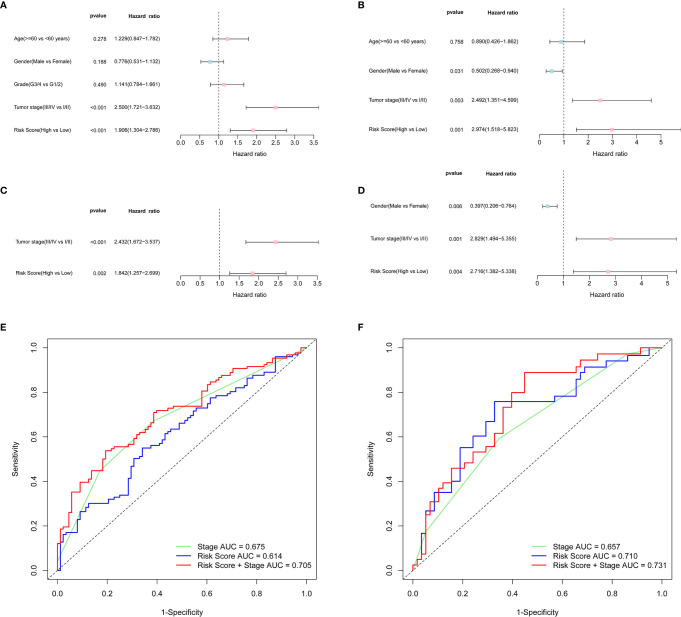
OS-related factors were screened, and the prognostic accuracy of risk score and clinicopathological factors were compared. TCGA cohort (A, C, E), ICGC cohort (B, D, F). (A, B) OS-related factors were screened by Univariate Cox regression analyses. (C, D) OS-related factors were screened by Multivariate Cox regression analysis. (E, F) Time-dependent ROC curve was used to compare the prognostic accuracy of risk score, tumor stage, and the combination of risk score and tumor stage in 3-year.